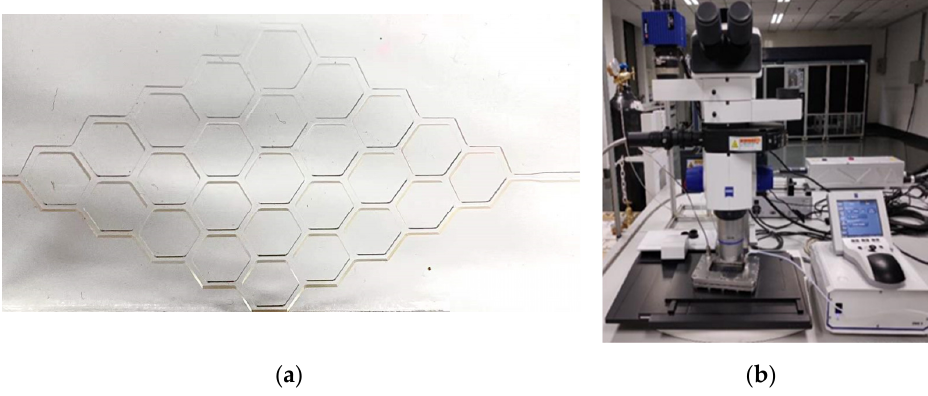
Figure 2. ( a ) The photo of honeycomb-shaped reactor; ( b ) Description Micro-PIV photographing platform.